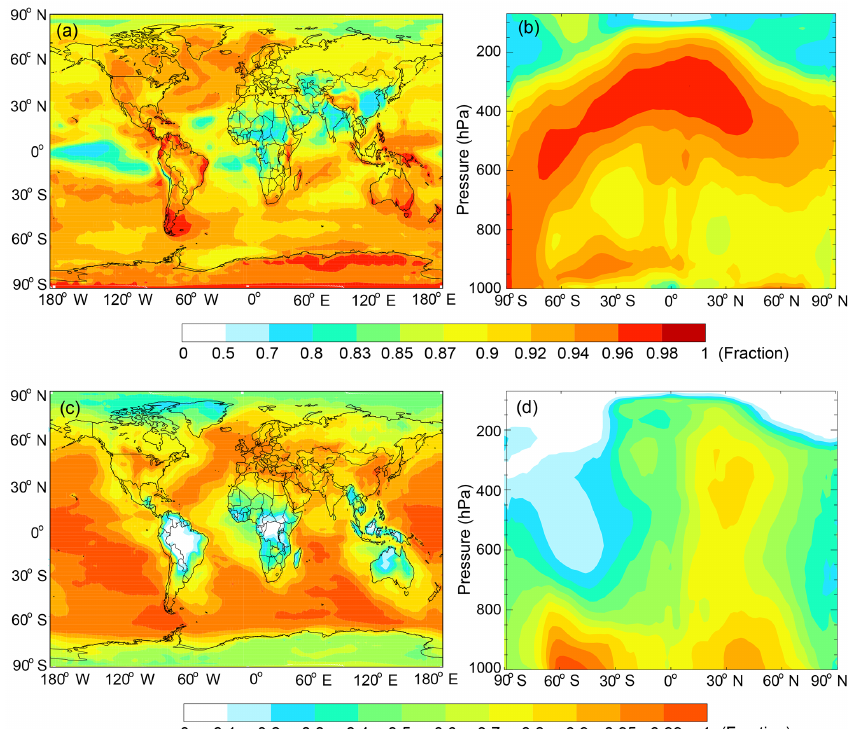
Figure 4. GEOS-Chem simulated annual mean contribution of condensation to total BC aging rate (sum of condensation and coagulation) averaged within 0–1km above the surface (top left) and zonally (top right) and annual mean contribution of H 2 SO 4 –HNO 3 –NH 3 conden- sation to the BC aging rate through total condensation (sum of H 2 SO 4 –HNO 3 –NH 3 and SOA condensation) averaged within 0–1km above the surface (lower left) and zonally (lower right). Model results are for